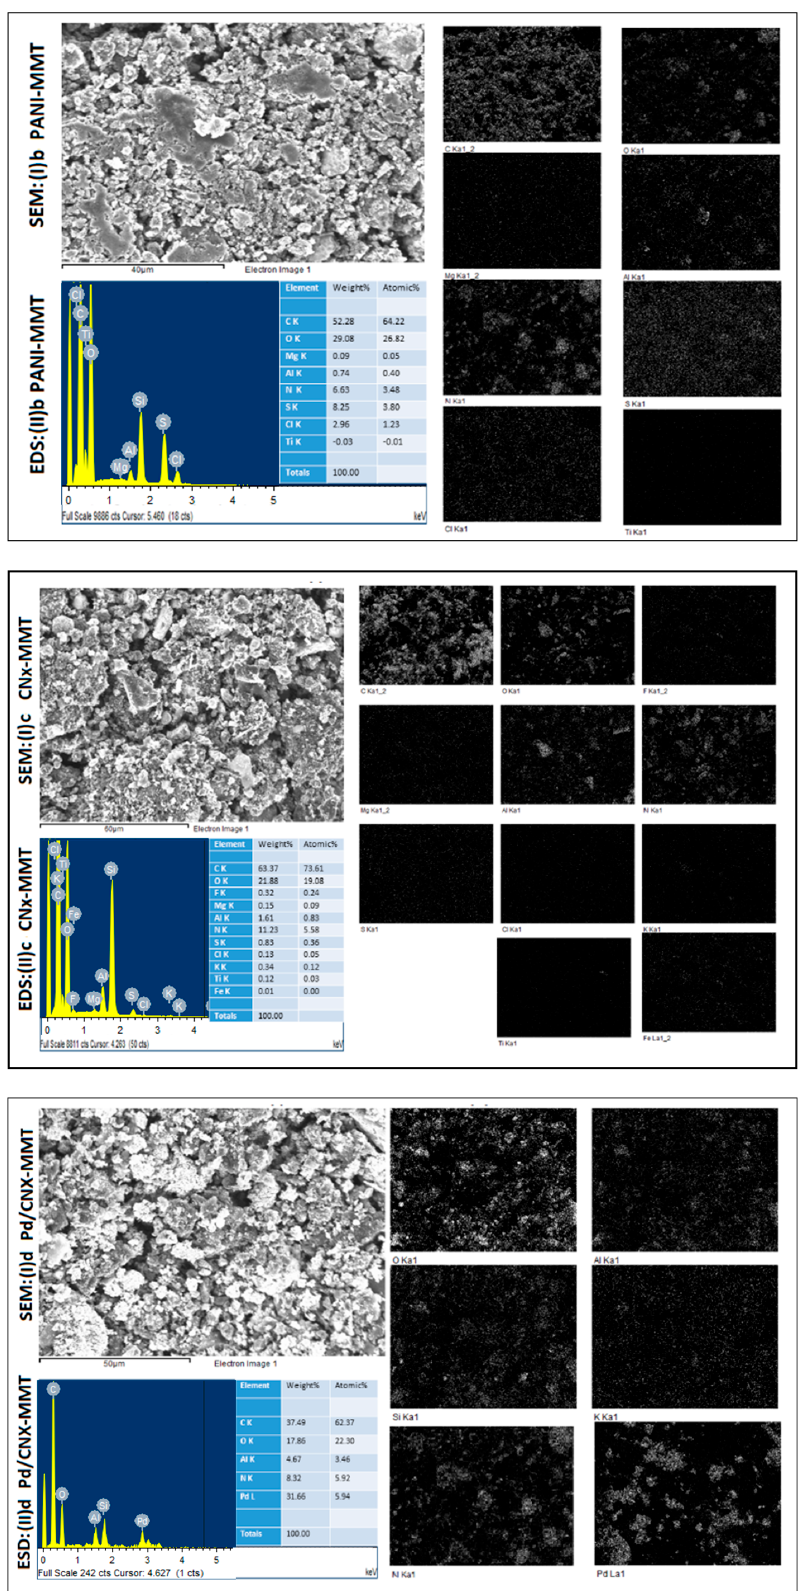
Figure 4. ( I ) SEM images of ( I )a HMMT, ( I )b PANI–HMMT ( I )c CNx-HHMT, ( I )d Pd/CNx-HHMT and 4( II ) EDX of ( II )a HMMT, ( II )b PANI–HMMT ( II )c CNx-HHMT, ( II )d